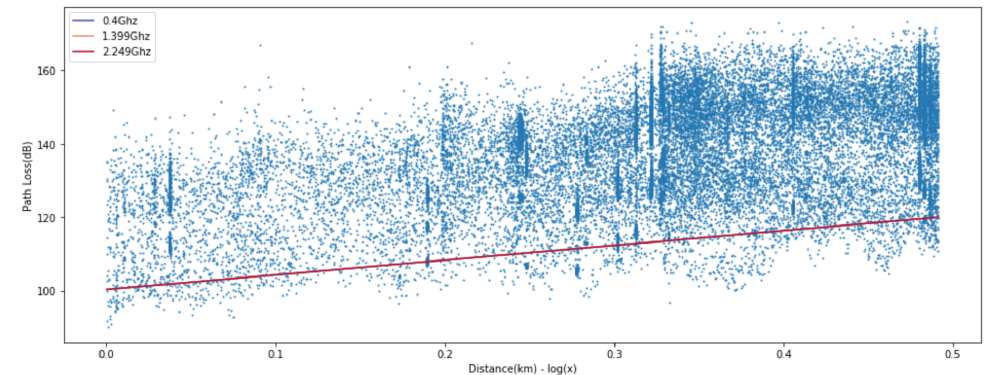
Figure 14. Path loss prediction based on two-ray